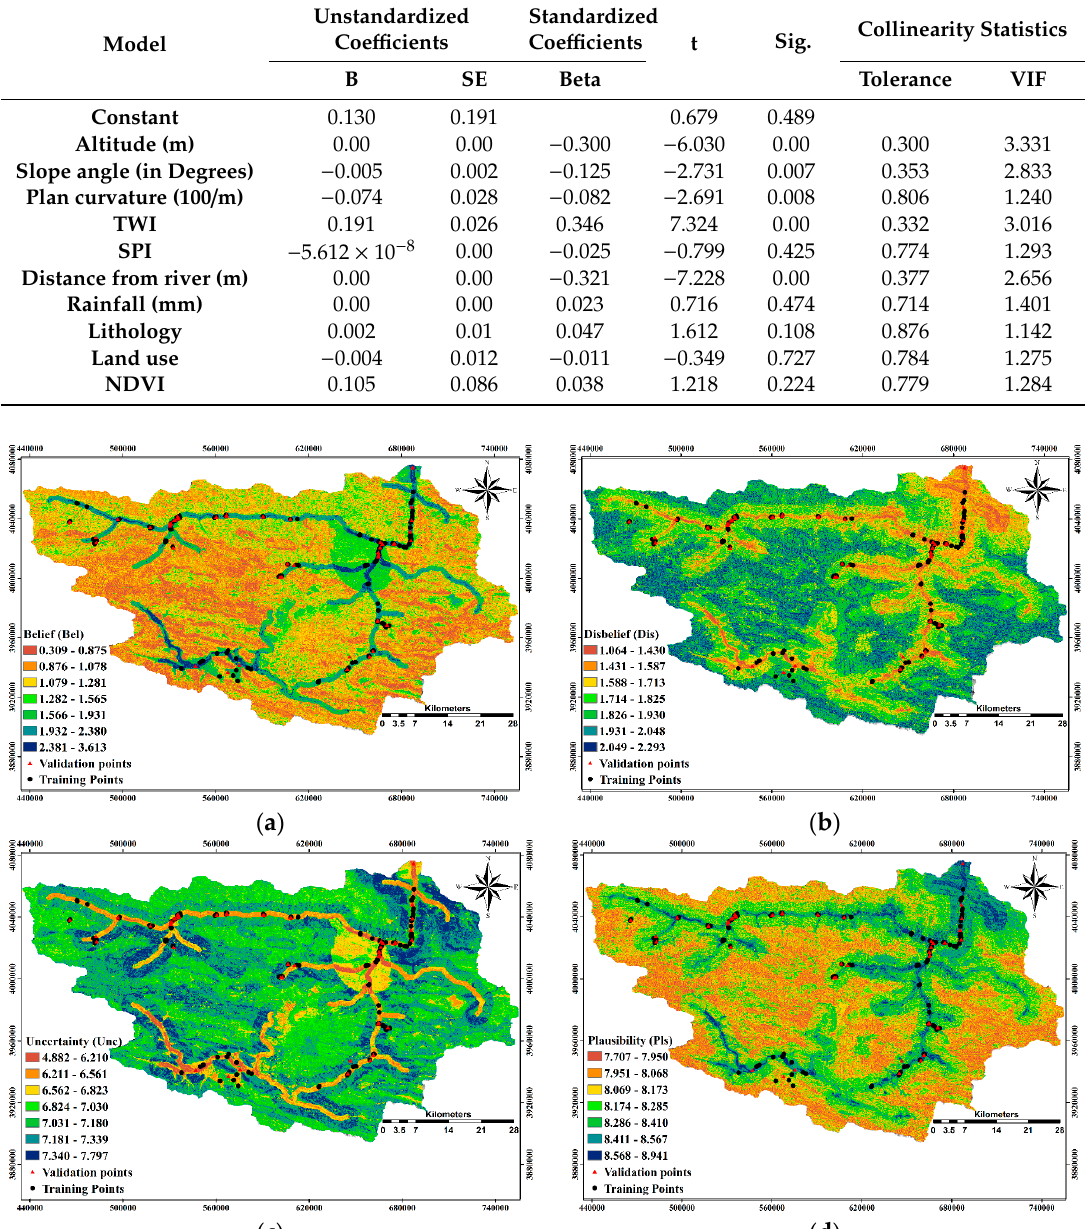
Table 4. The B coe ffi cients and multicollinearity diagnosis indices for independent variables in the LR model.